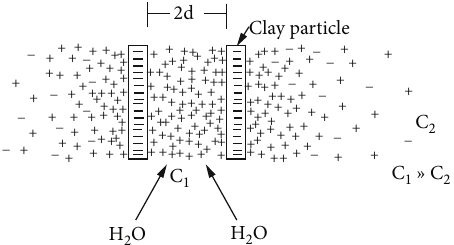
Figure 2: Illustration of osmotic swelling of the clay particle